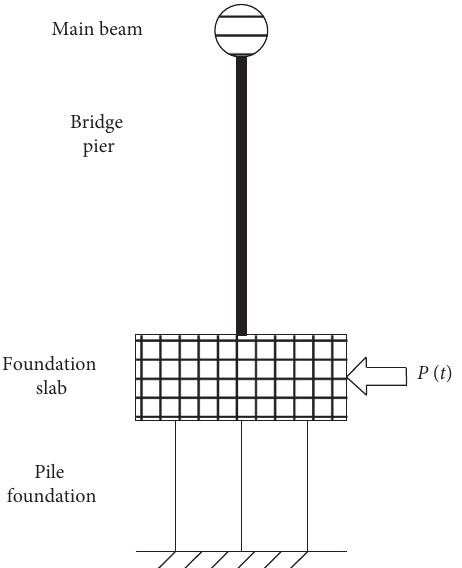
Figure 1: Analytical model of forced vibration of a ship hitting a